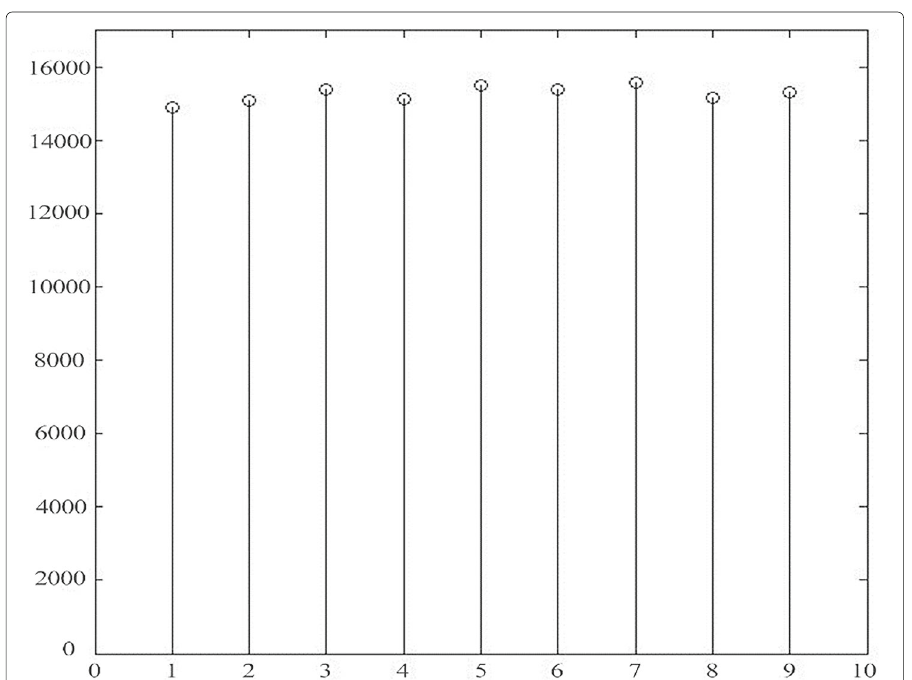
Fig. 5 Numbers of shuffling keys by which the encoding parameter w =1, 2, ..., or 9 were extracted